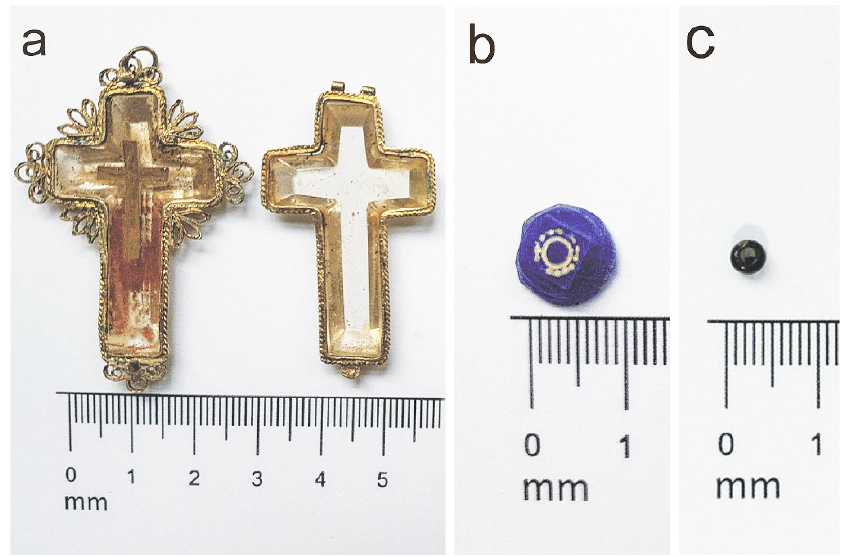
Figure 3. Items selected for detailed tests. ( a ) The reliquary cross from opening no. 11B. ( b ) The blue bead from opening no. 24A. ( c ) The black bead from opening no. 3A.